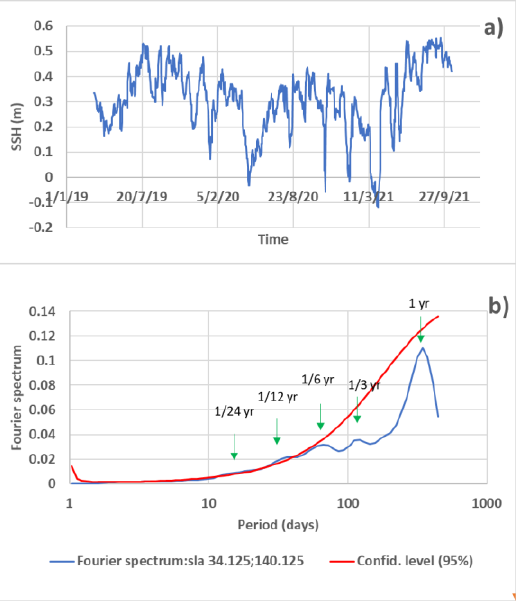
Figure 1. The SSH anomaly at 34.125° N, 140.125° E – ( a ) the raw signal – ( b ) the Wavelet Fourier spectrum (adimentional) and the main harmonics. SSH data is provided by the National Oceanic and Atmospheric Administration (NOAA) https://coastwatch.noaa.gov/pub/socd/lsa/rads/sla/daily/nrt/ (accessed on 27 April 2022).